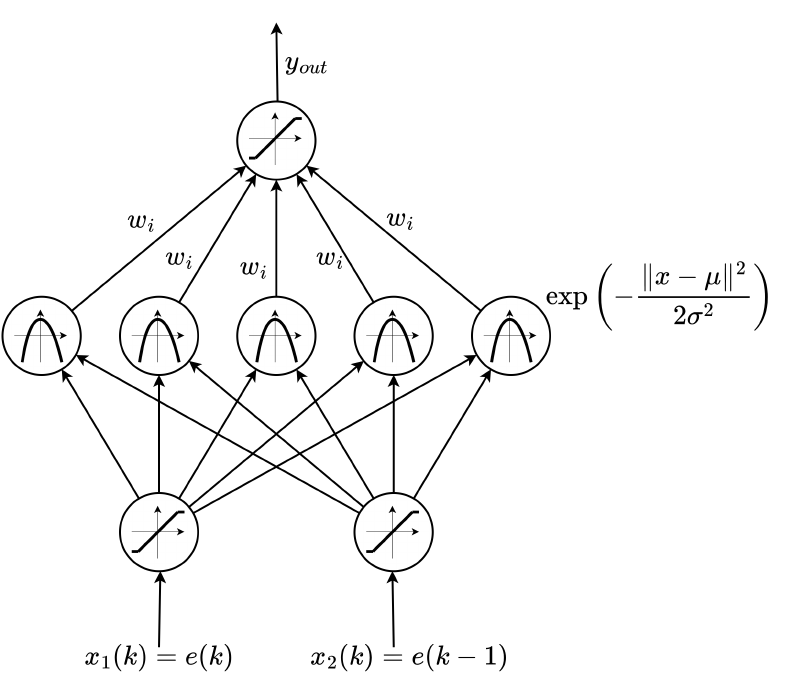
Figure 1. Structure of the Radial Basis Function Neural Network.